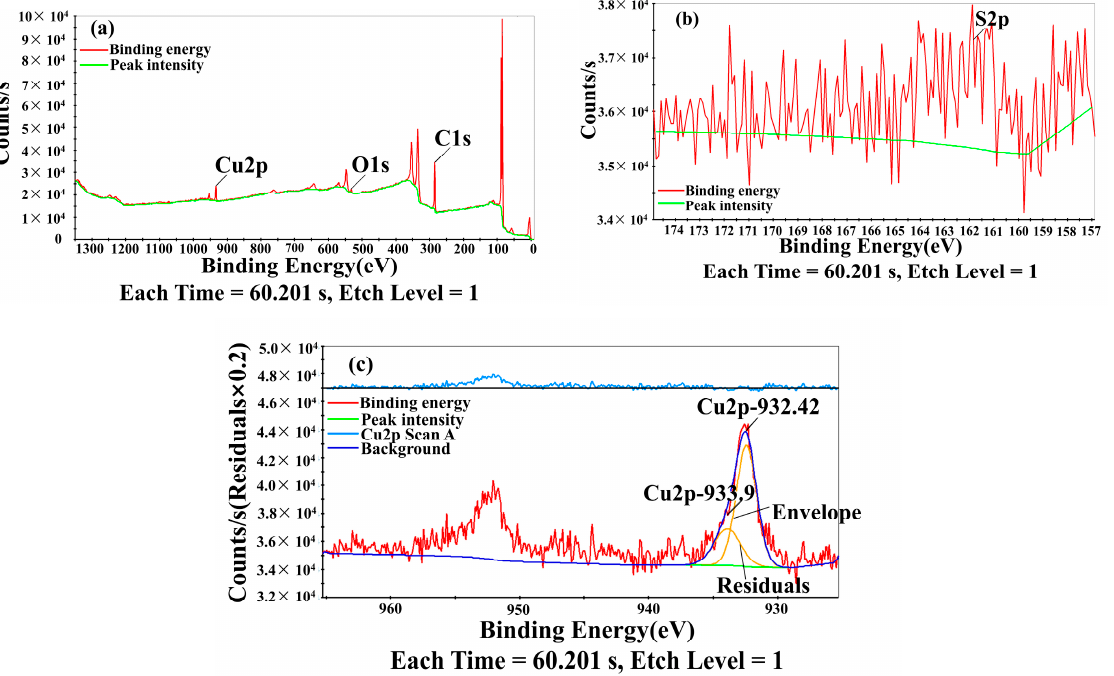
Figure 8. XPS energy spectrum of the contact surface in insulating oil after 120 min sliding at the speed of 119 mm/s. ( a ) Overall test results, ( b ) energy spectrum of sulfur element, ( c ) Cu peak